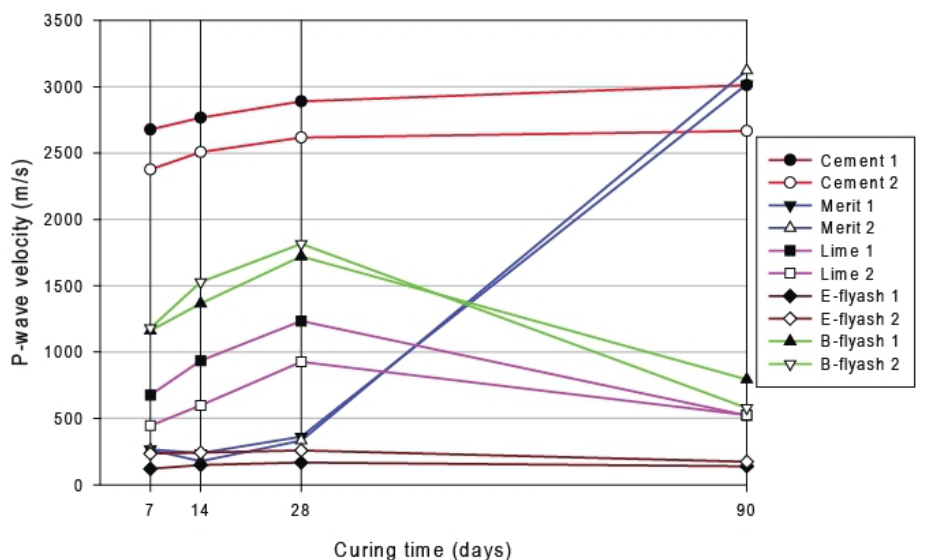
Figure 6. P-wave velocity as a function of curing time for individual